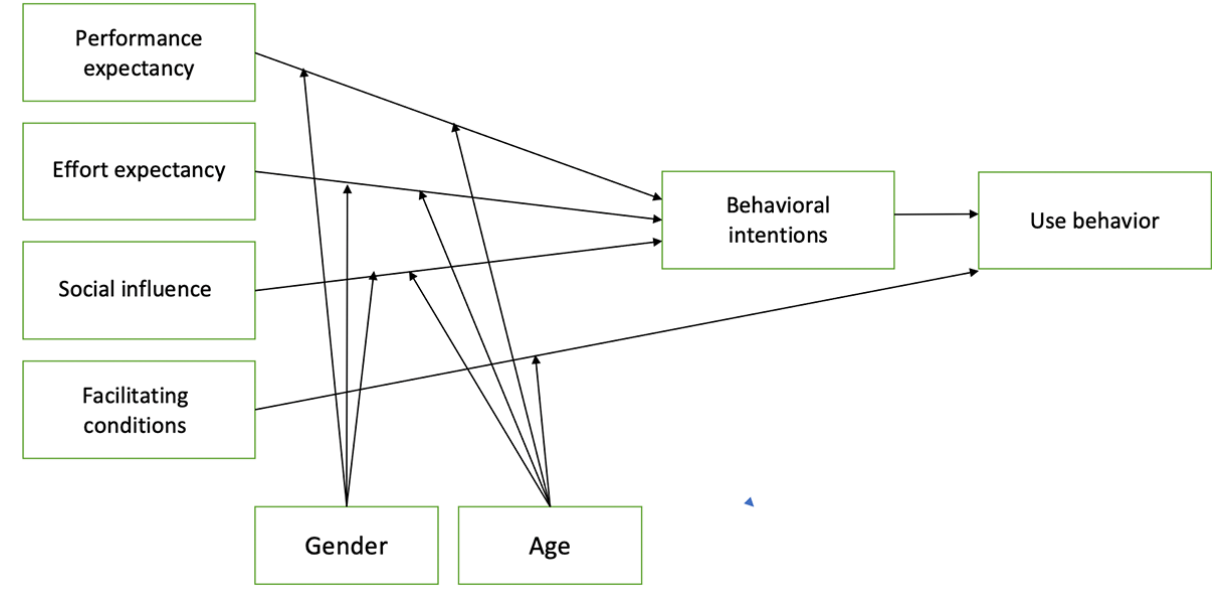
Figure 2. The Unified Theory of Acceptance and Use of Technology model with age and gender as the moderator